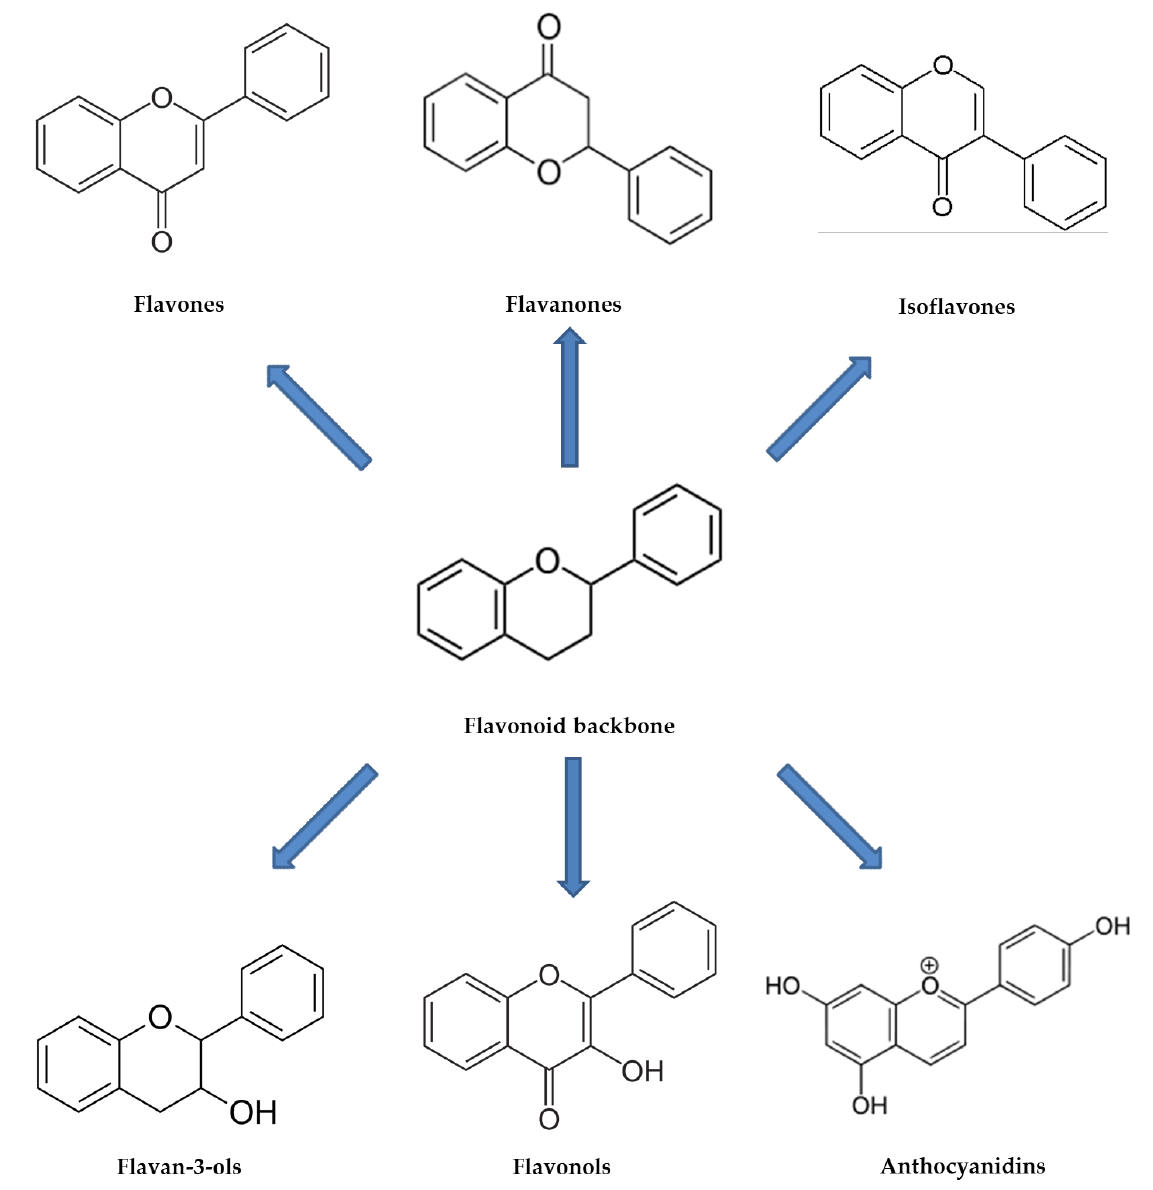
Figure 2. Representation of basic structures of flavonoid subclasses.